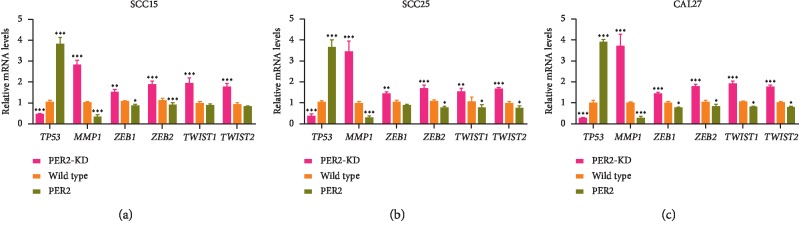
PER2 controls the EMT process in OSCC. (a-c) Quantitative RT-PCR analysis of EMT-associated genes in SCC15 (a), SCC25 (b), and CAL27 (c). ∗P < 0.05, ∗∗P < 0.01, and ∗∗∗P < 0.001.